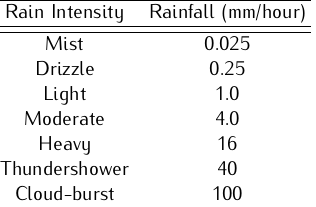
Table 6. Representative rainfall